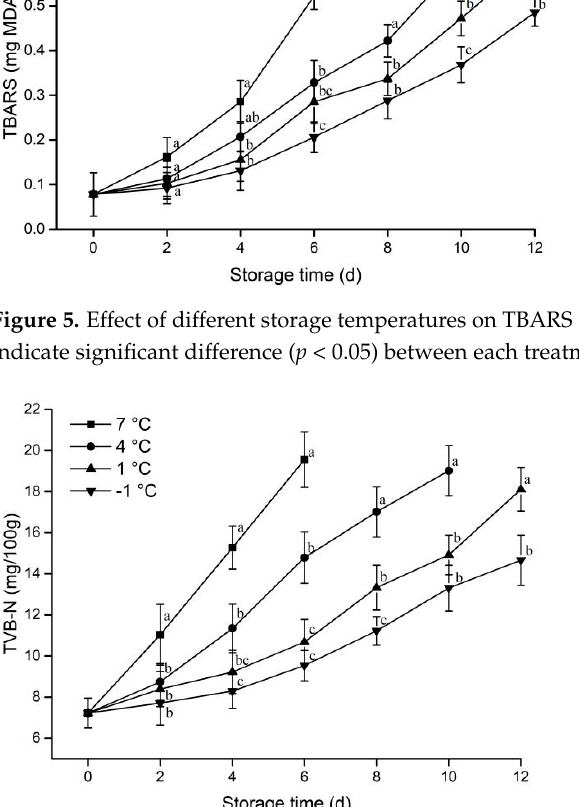
Figure 6. Effect of different storage temperatures on TVB-N of pork. Different lowercase letters (a − c) indicate significant difference (p < 0.05 ) between each treatment on the same storage time.